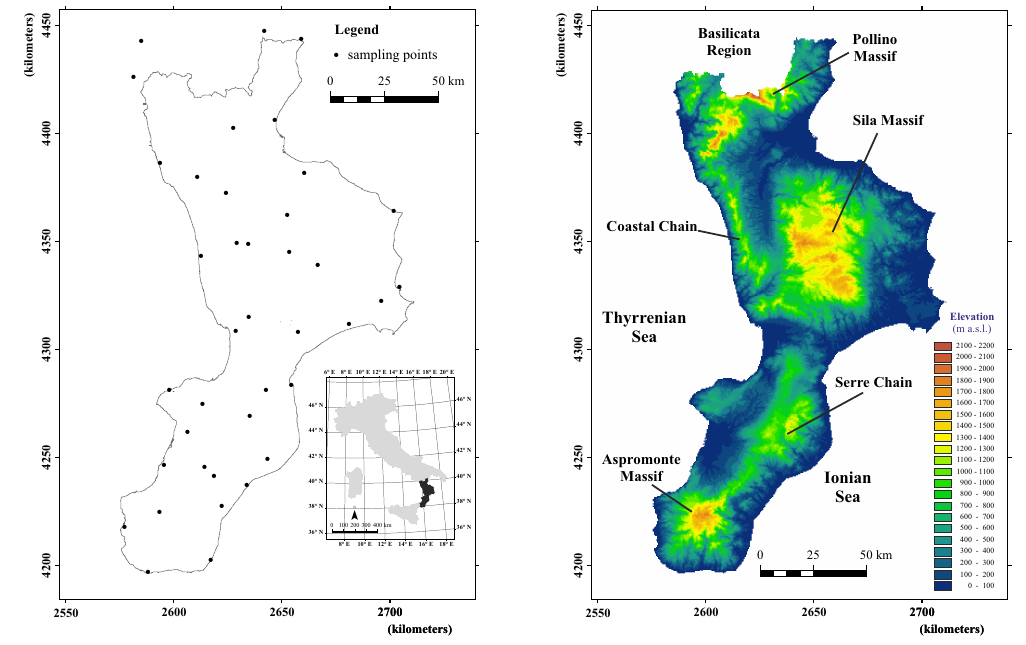
Fig. 1. Digital elevation model (right) of the study area and location (left) of the weather stations